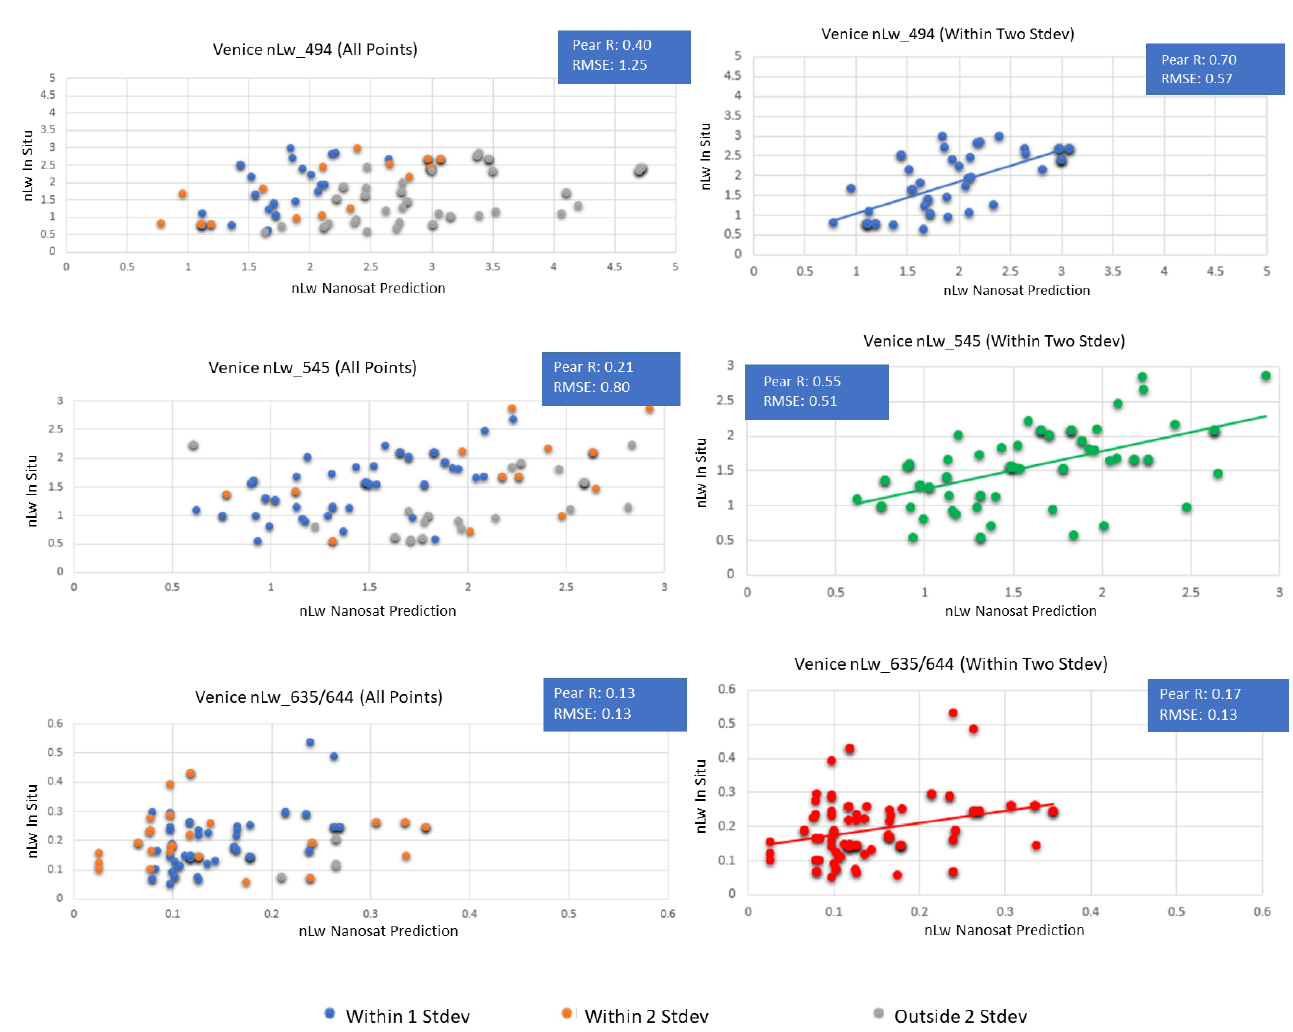
Figure 10. Planet PlanetScope predicted nLw vs. Venice AERONET-OC in situ nLw. Top left : nLw_494 unfiltered. Top right : nLw_494 filtered. Middle left : nLw_545 unfiltered. Middle right : nLw_545 filtered. Lower left : nLw_635/644 unfiltered. Lower right : nLw_635/644 filtered.